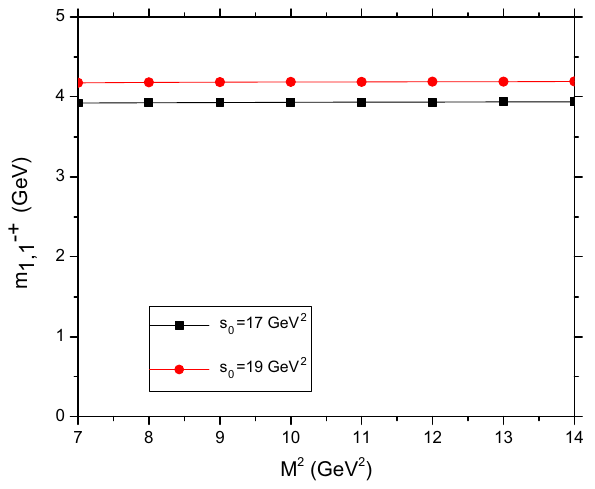
Fig. 4 Borel parameter dependence of J PC = 1 −+ meson mass from (cid:10) ( 1 ) μναβ for different s 0 values